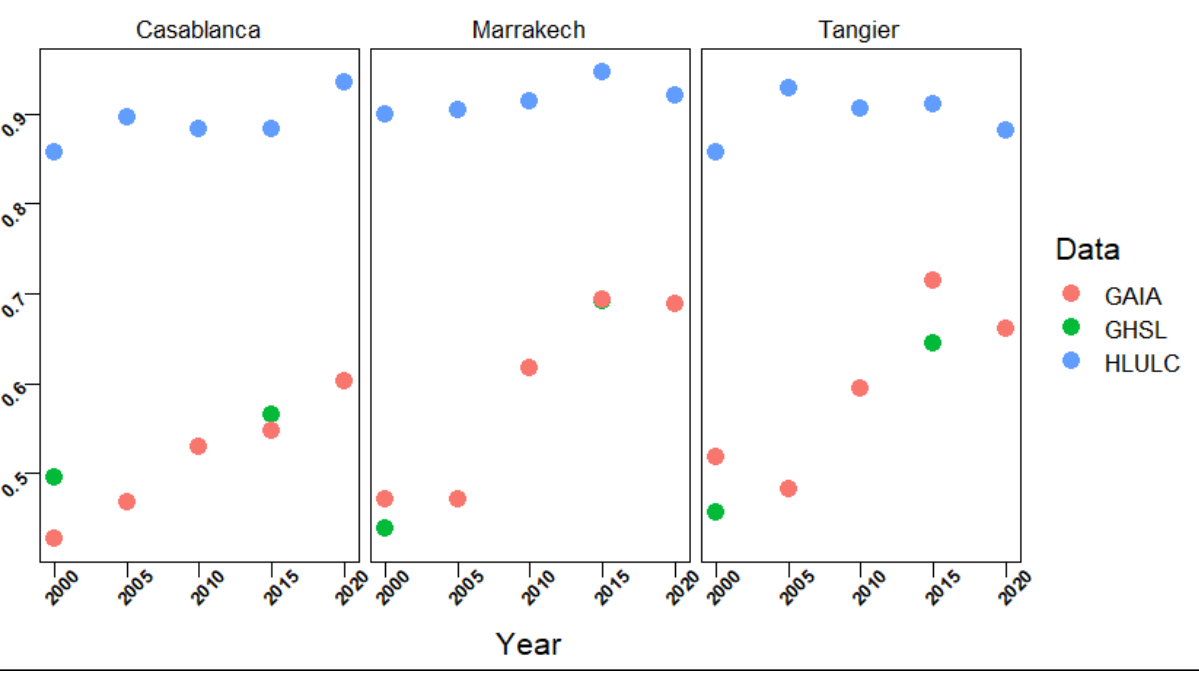
Figure 4. F ‐ score in the 3 databases (GHSL, GAIA and HLULC) between 2000 and